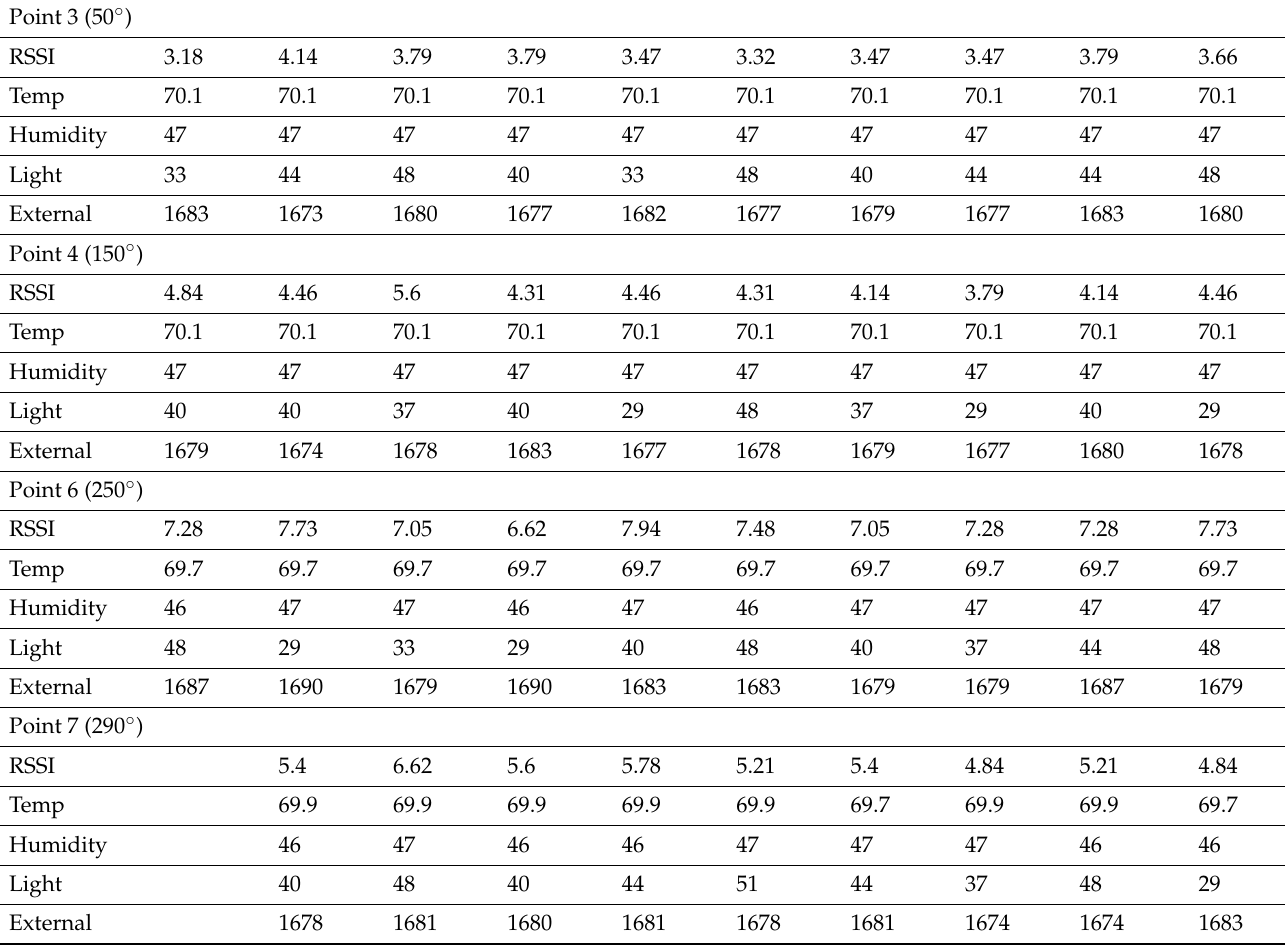
Table 3. Dipole Antenna Sensed